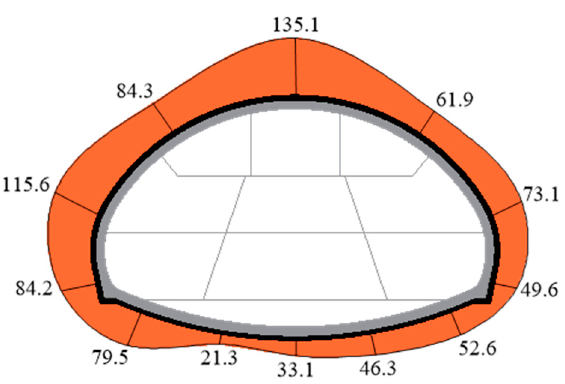
Figure 24. Final distribution of the contact pressures between the primary and secondary supports.